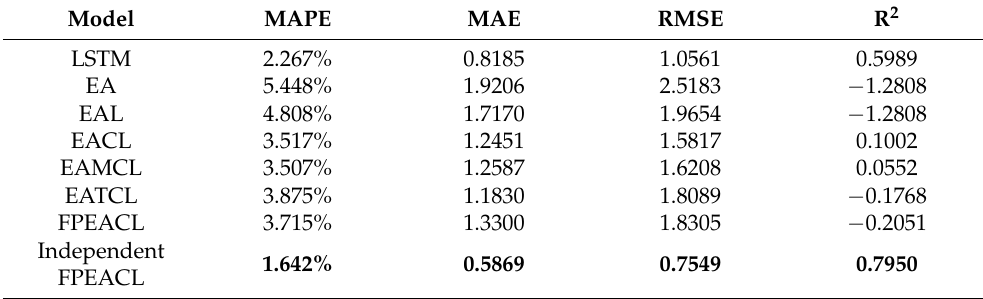
Figure 9. Comparison of independent load forecasting results for the monthly seasonal inflection points. Table 6. Comparison of independent load forecasting result indicators for the monthly seasonal inflection points.